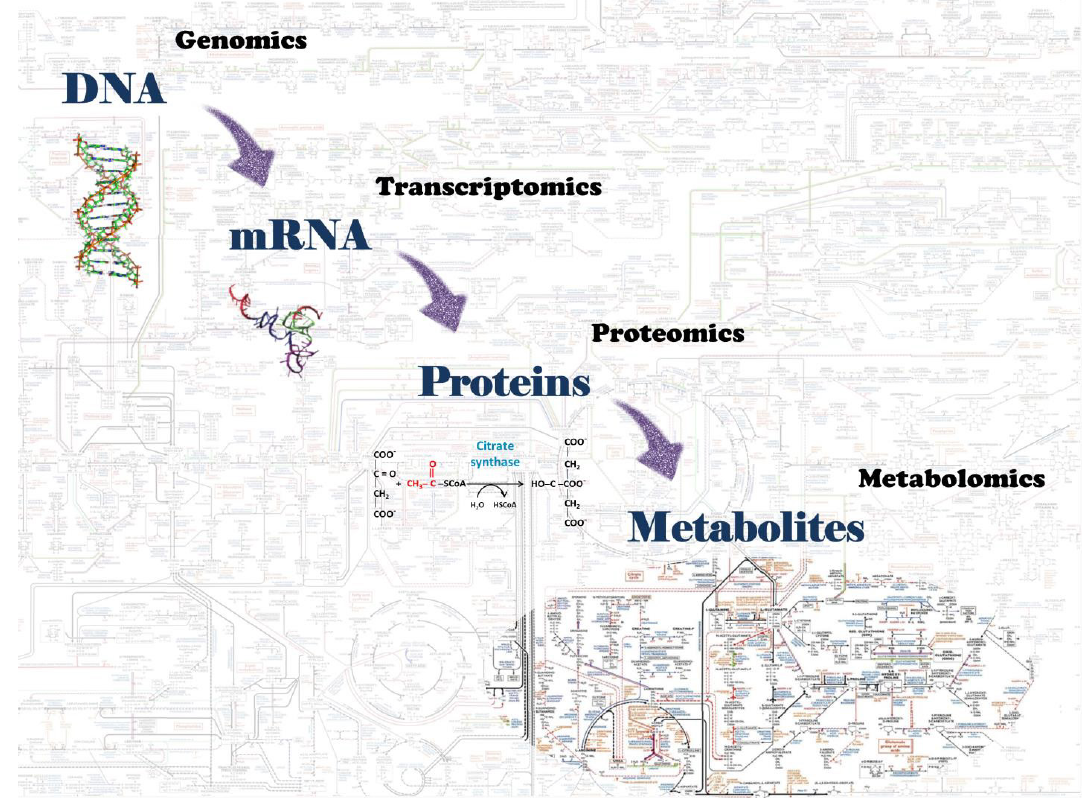
Figure 1 - Omics science components of biological